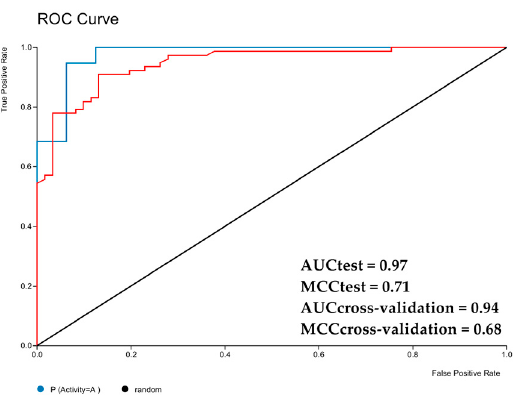
Figure 2. Receiver operating characteristic (ROC) plot of sensitivity versus 1-specificity, of the selected RF model for cross-validation (red line) and test sets (blue line). AUC = area under the curve; MCC = Matthews correlation coefficient.